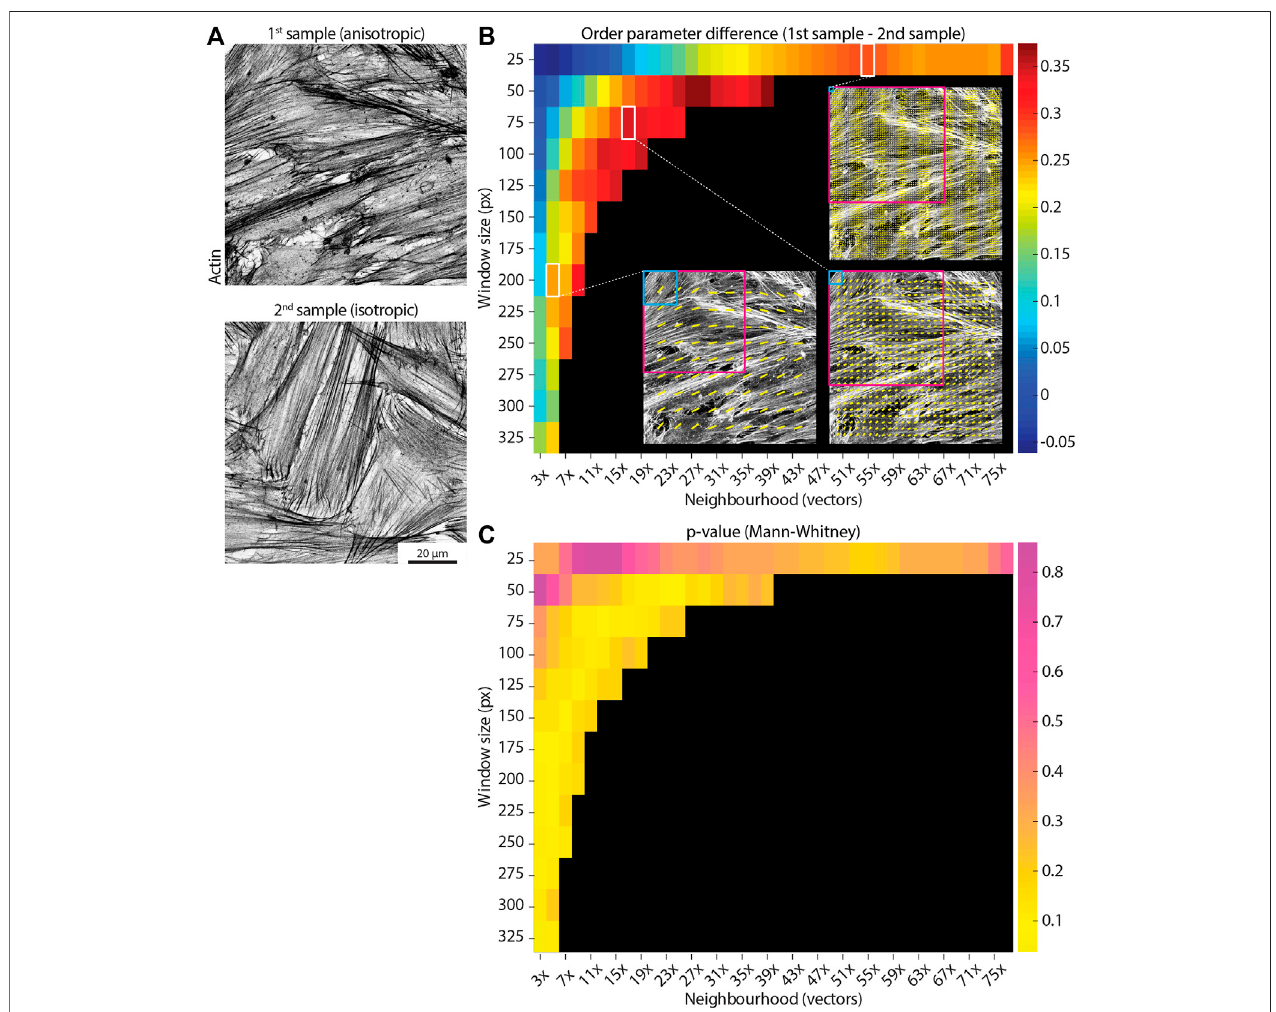
FIGURE 4 | Determining the optimal length scale difference. (A) Example actin images taken from two separate samples and displaying different degrees of alignment (higher on the left, more anisotropic; lower on the right, more isotropic). Scale bar, 20 μ m . (B) The parameter search runs the analysis for a range of window sizes(y-axis,from25 px to325 px )andarangeofneighborhoodsizes( x -axis,from3 x to77 x vectors,wheretheneighborhoodsizeisde fi nedas2* neighborhoodradius + 1). Each permutation of window and neighborhood represents a length scale. Each colored square shows the difference in the median order parameter between theanisotropicsampleandtheisotropicsample(meanvaluesover10imagesforeachsample)foraspeci fi cpairofwindowandneighborhoodsizes.Smallwindowsizes pairedwithsmallneighborhoods(upperleftcorner)displaynoisyoutput,duetothelimitedamountofimageinformationavailabletoprocess.Threeexamplevector fi elds are shown for a window size of 25 px and neighborhood of 55 x vectors (corresponding to 92 μ m ), 75 px and 17 x vectors (89 μ m ), and 200 px and 5 x vectors (79 μ m ), with the light blue and magenta squares showing the size of the window and neighborhood respectively. Despite relatively similar neighborhood sizes, the output varies dependingonthesizeoftheexaminedwindow.Readingthegraphhorizontallyfromlefttorightforeachwindowsizeupto ∼ 150 px ,itispossibletonotehowanoptimal length scale of ∼ 90 μ m is detected (i.e., a peak difference value is displayed), likely correlated to relevant biological dimensions (e.g., cell size). (C) A similar graph to the one in (B) is shown for the p -value of Mann-Whitney tests between the two samples for all the combinations of window and neighborhood sizes. In this case, greater differences are represented by lower values (yellow).